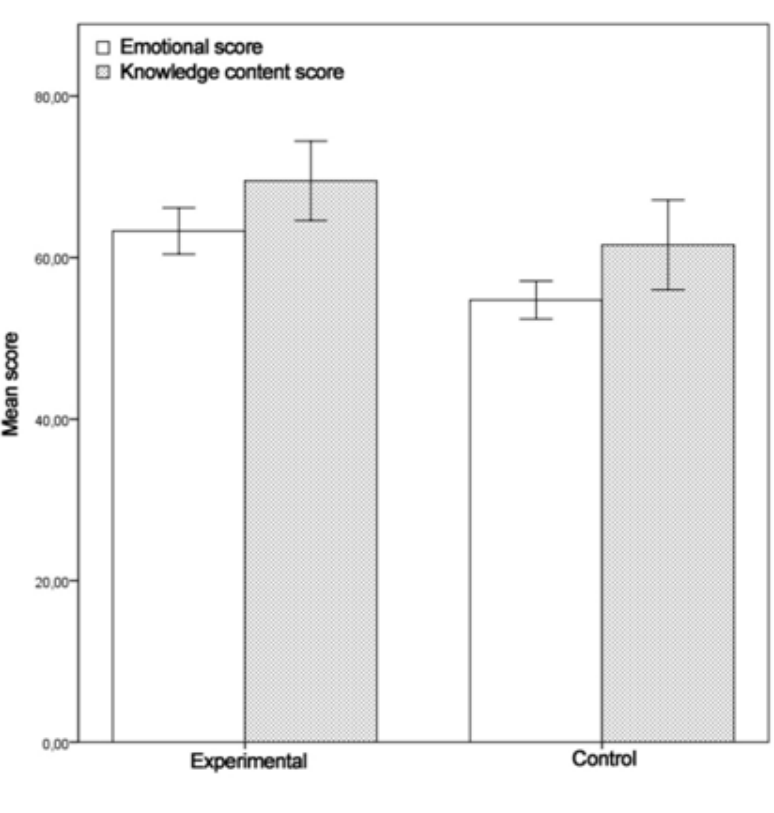
Figure 2. Mean score for emotional and knowledge content in post- test evaluation for Experimental and Control group. Confidence interval for error bars of